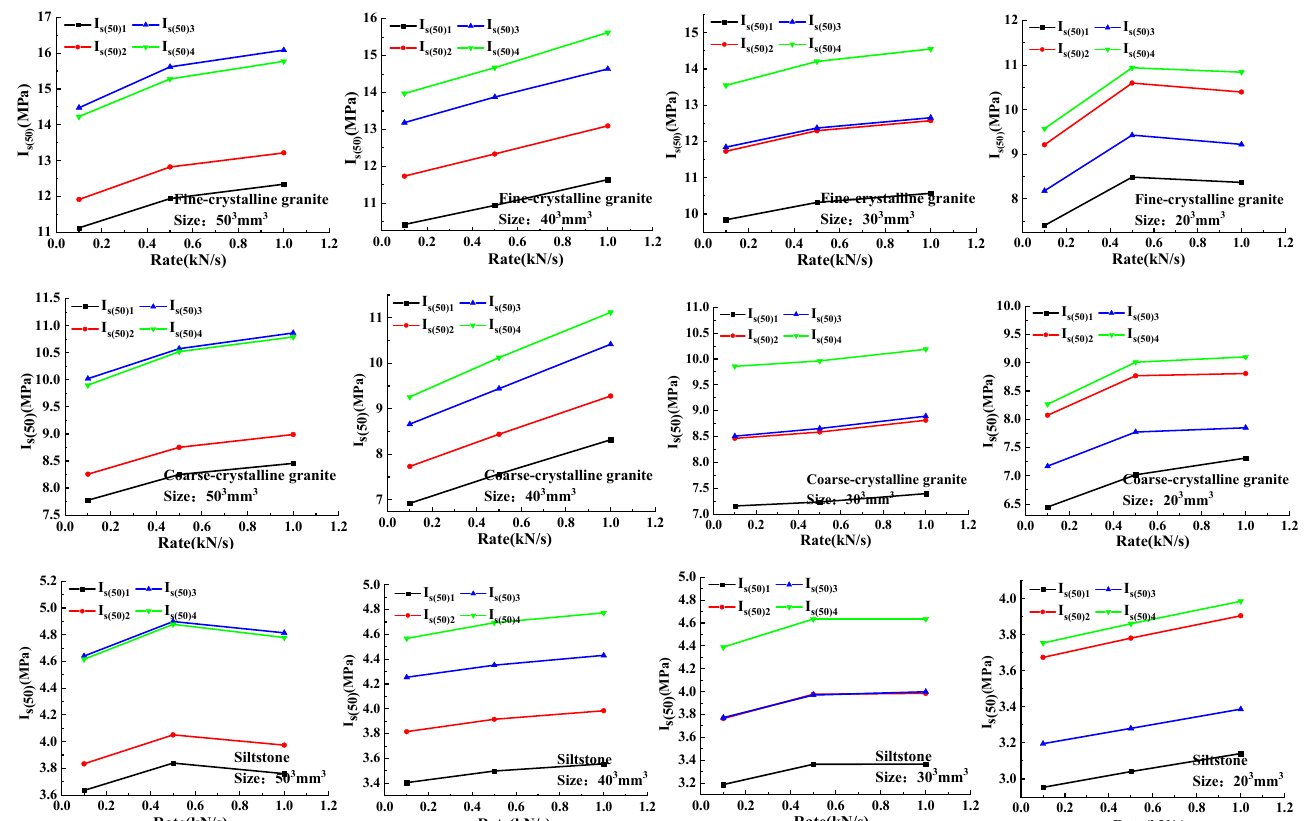
Figure 7. Relationship between I s(50) and loading rate for three rock samples with different sizes.